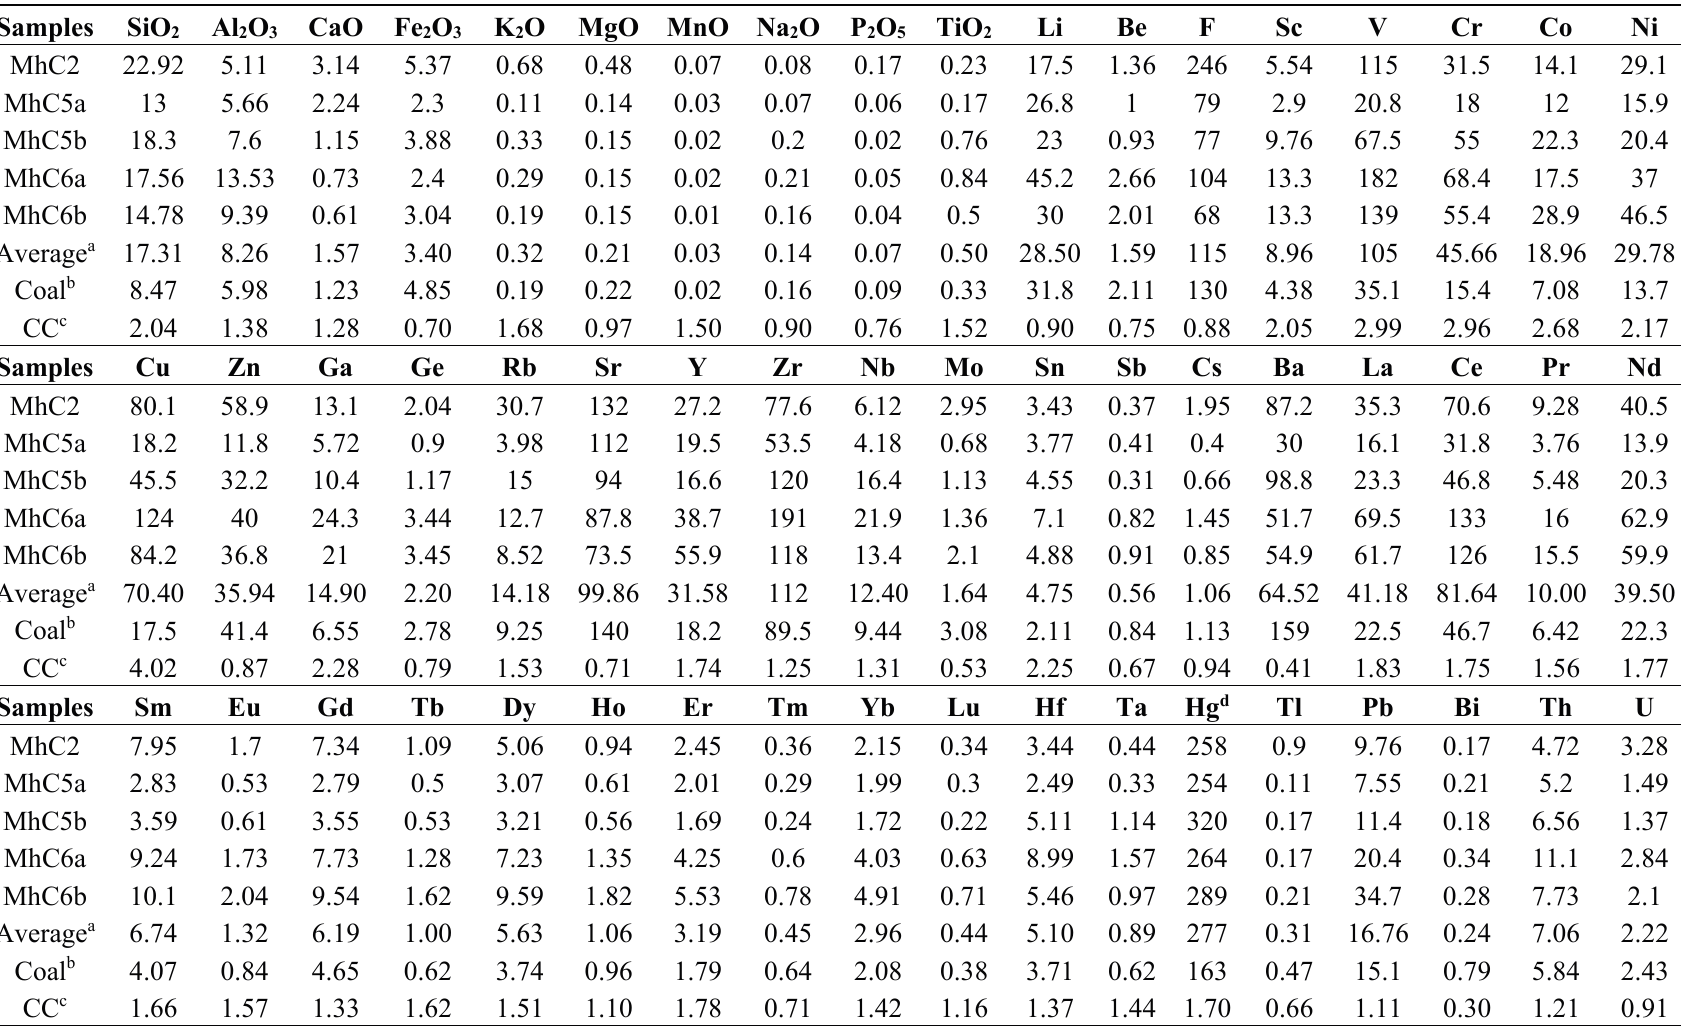
Table 3. Contents of oxides of major elements and trace elements in the Mahe coals from northeastern Yunnan, China (in μ g/g unless as indicated). Samples